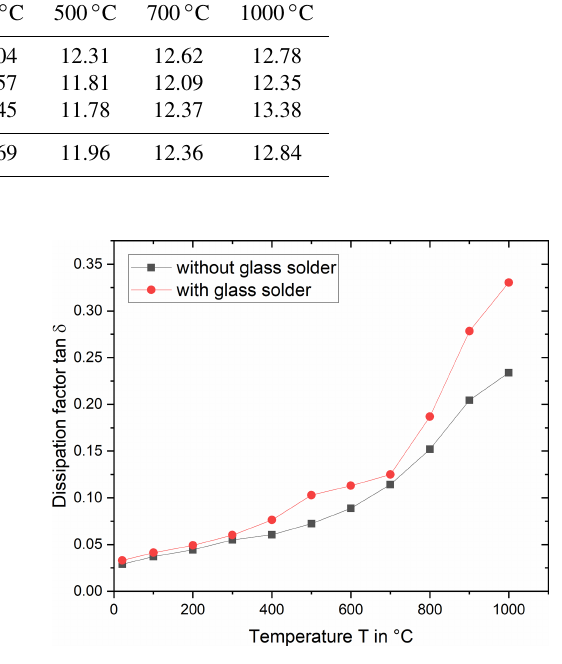
Figure 21. Dissipation factor, tan δ , with and without glass solder, up to 1000 ◦ C.